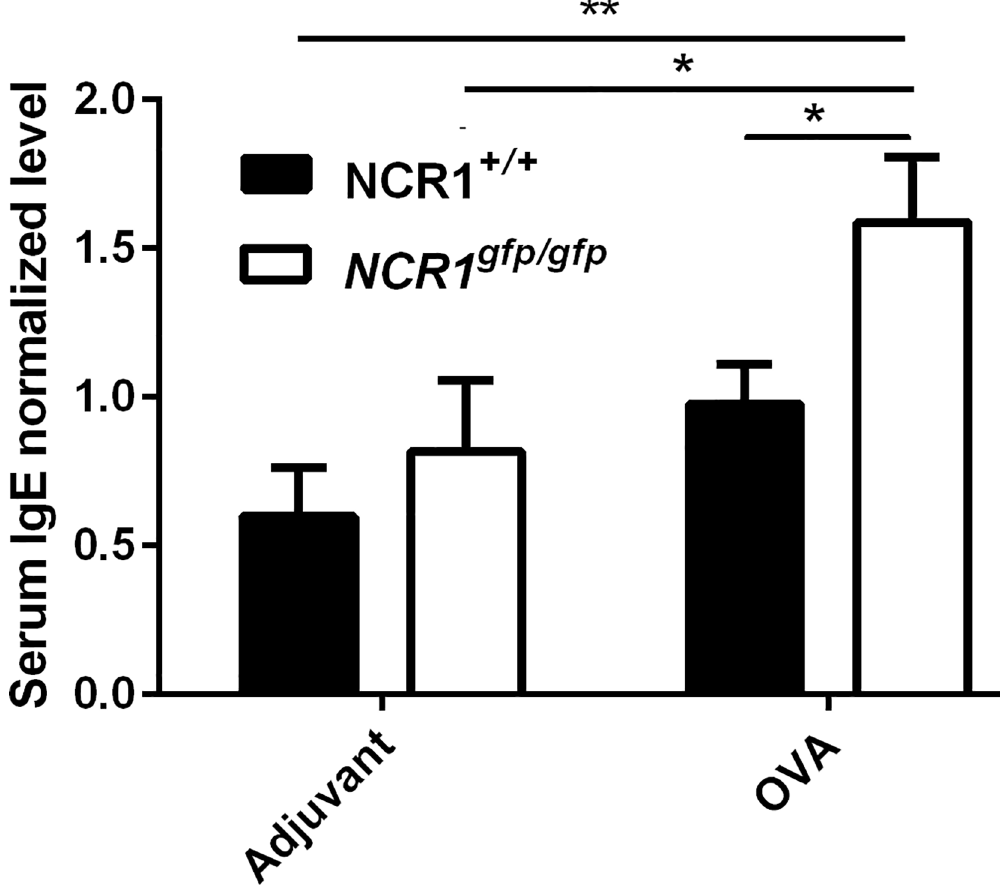
Fig 1. Increased IgE production in the absence of NCR1. NCR 1 +/+ and NCR1 gfp/gfp C57Bl/6 mice were i.p. immunized with either OVA/Alum or adjuvant only on days 0 and 14. Ten days after the second immunization, mice were challenged twice intranasally with OVA at days 24 and 27. Twenty four h following the second challenge, serum was drawn for measurement of the total IgE levels (n = 8 to 11). Results are the summary of 2 independent experiments and were normalized according to the OVA immunized NCR1 +/+ group average that was considered as 1 in each experiment. * p < 0.05; ** p < 0.01 1 way ANOVA multiple comparisons,